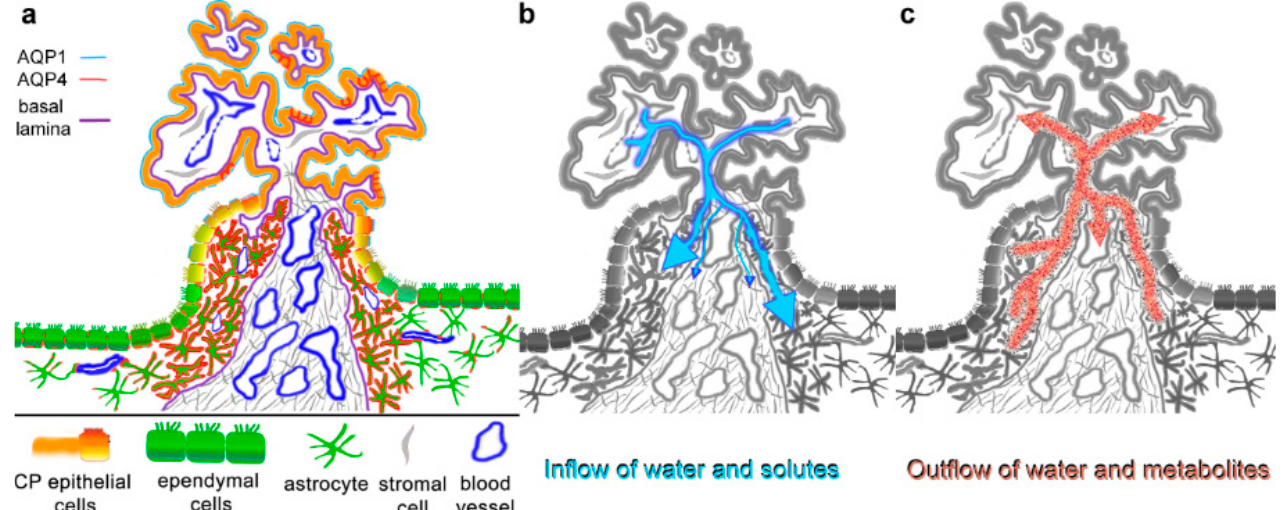
Figure 5. Summary and suggested implications of aquaporin expressions in the ependyma–choroid plexus transition zone. ( a ) AQP4 expression is particularly high in astrocytic processes that form a glial plate or cuff around the blood-supplying vessels of the CP. AQP4 staining is also found basolaterally in some CP epithelial cells (red lines). The astrocytic processes delimited by a basal lamina reach the CP stroma, which includes fenestrated capillaries. AQP1 is expressed mostly apically in CP epithelial cells, which also form tight junctions as the basis for the blood–CSF barrier. Note that the basal lamina of blood vessels is not included in the schematic. ( b ) Water and solutes can diffuse into the CP stroma through fenestrated capillaries and can enter the brain parenchyma via the glial plate. The basal laminae might have a filtering effect but do not constitute a barrier. Water flow is likely restricted by the dense meshwork of astroglial processes in the glial plate. ( c ) Depending on the osmotic gradient, the high density of AQP4 water channels in the glial plate could also serve as a drainage and clearing pathway for metabolites, which are then taken up by postcapillary venules in the stroma. This would contribute significantly to processes suggested by the glymphatic pathway hypothesis.